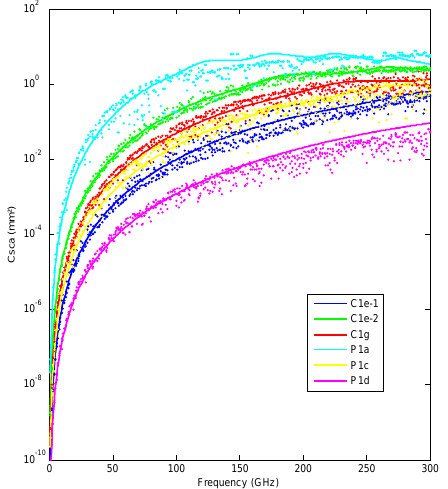
Fig. 4. Csca of arbitrary oriented pristine ice crystals as a function of the frequency. As a reference in each case the curve of an equal volume sphere is given.